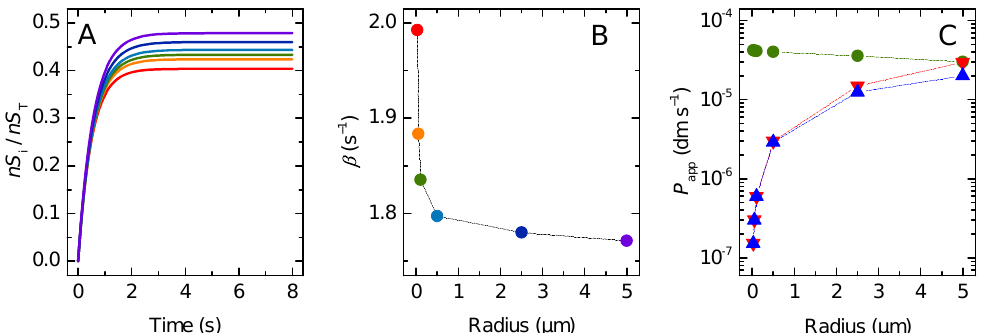
Figure 5. Permeation of very lipophilic solutes, K p = 10 4 . ( A ) Variation of the fraction of solute molecules inside the vesicles (membrane inner leaflet plus aqueous medium) with 25 nm ( — ), 50 nm ( — ), 0.1 µ m ( — ), 0.5 µ m ( — ), 2.5 µ m ( — ) and 5 µ m radius ( — ). ( B ) Effect of the vesicle radius on the characteristic constant of solute equilibration. ( C ) Apparent permeability coefficient calculated from the general equation ( P app • ), and from the simplified equation ( P r app (cid:72) and P rV app (cid:78) ). Note the logarithmic scale of the y axis. The dotted lines in panels B and C are guides for the